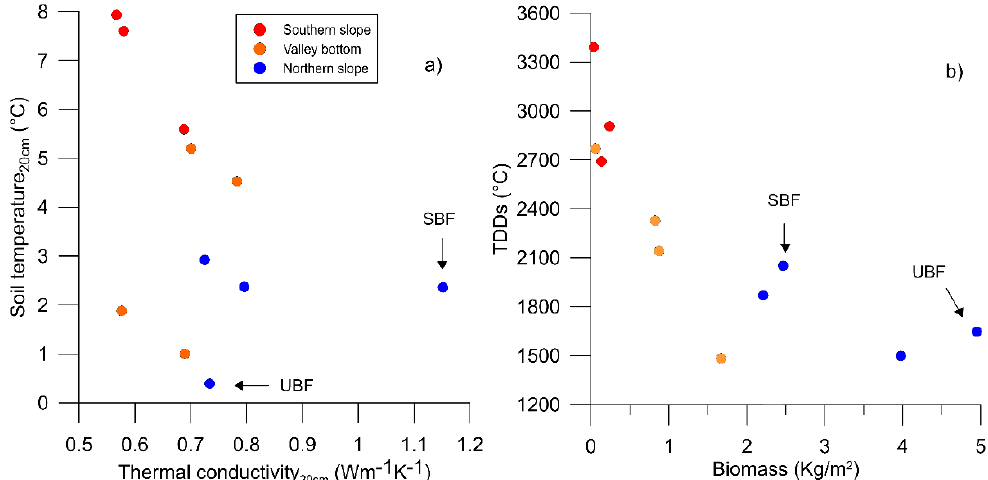
Figure 4. Variability of thermal conductivity (at 20-cm depth) in relation to ground temperature at corresponding depth ( a ) and biomass, and their relationship with calculated surface thawing degree days (TDD s ) for 2016–2017 ( b ).